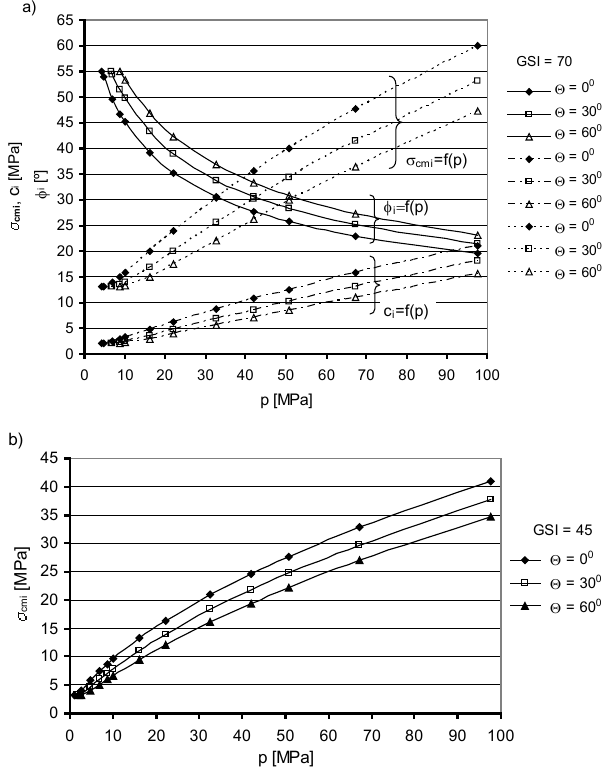
Fig. 4. Dependence of global compressive strength σ cmi , cohesion c i and internal friction angle ϕ i of the rock mass on the Lode angle Θ and the hydrostatic pressure p ; (a) GSI = 70, (b) GSI = 45 (only for σ cmi ) The analysis of the angle of Θ = 0 ° , Θ = 30 ° , Θ = 60 ° is illustrated by the conditions of triaxial compres- sion ( σ > σ = σ ), pure shear ( σ = ( σ + σ )/2) and 1 2 3 2 1 3 = σ > σ ), triaxial extension ( σ 1 2 3